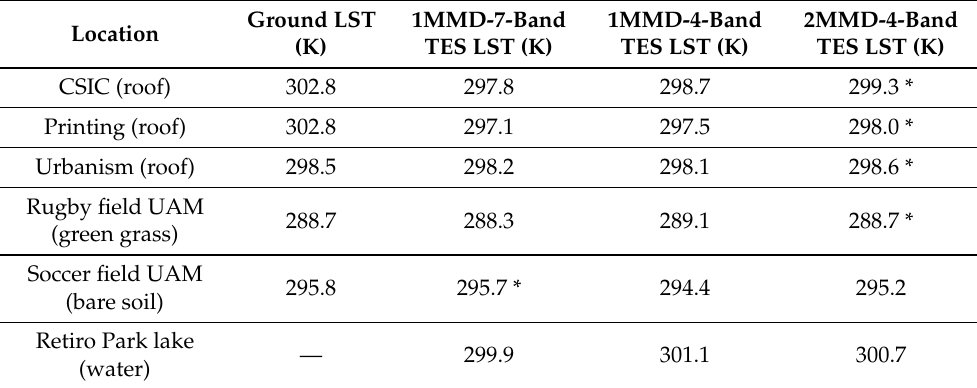
Table 7. LST values for each method and the ground LSTs the 4 of July 2008 during the nighttime. * indicates the retrieved LST closest to the ground